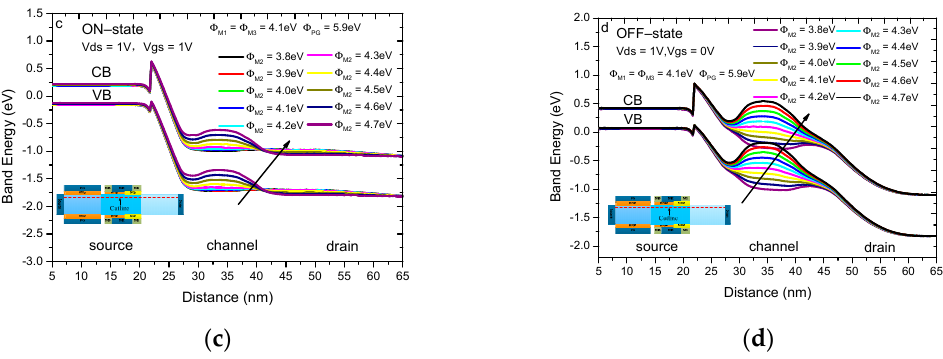
Figure 8. ( a ) Transfer characteristics of the DMGE-HJLTFET with different control gate workfunction ( Φ M2 ); ( b ) the distribution of electric field with different Φ M2 ; ( c ) the ON-state energy band diagram with different Φ M2 ; ( d ) the OFF-state energy band diagram with different Φ M2 .